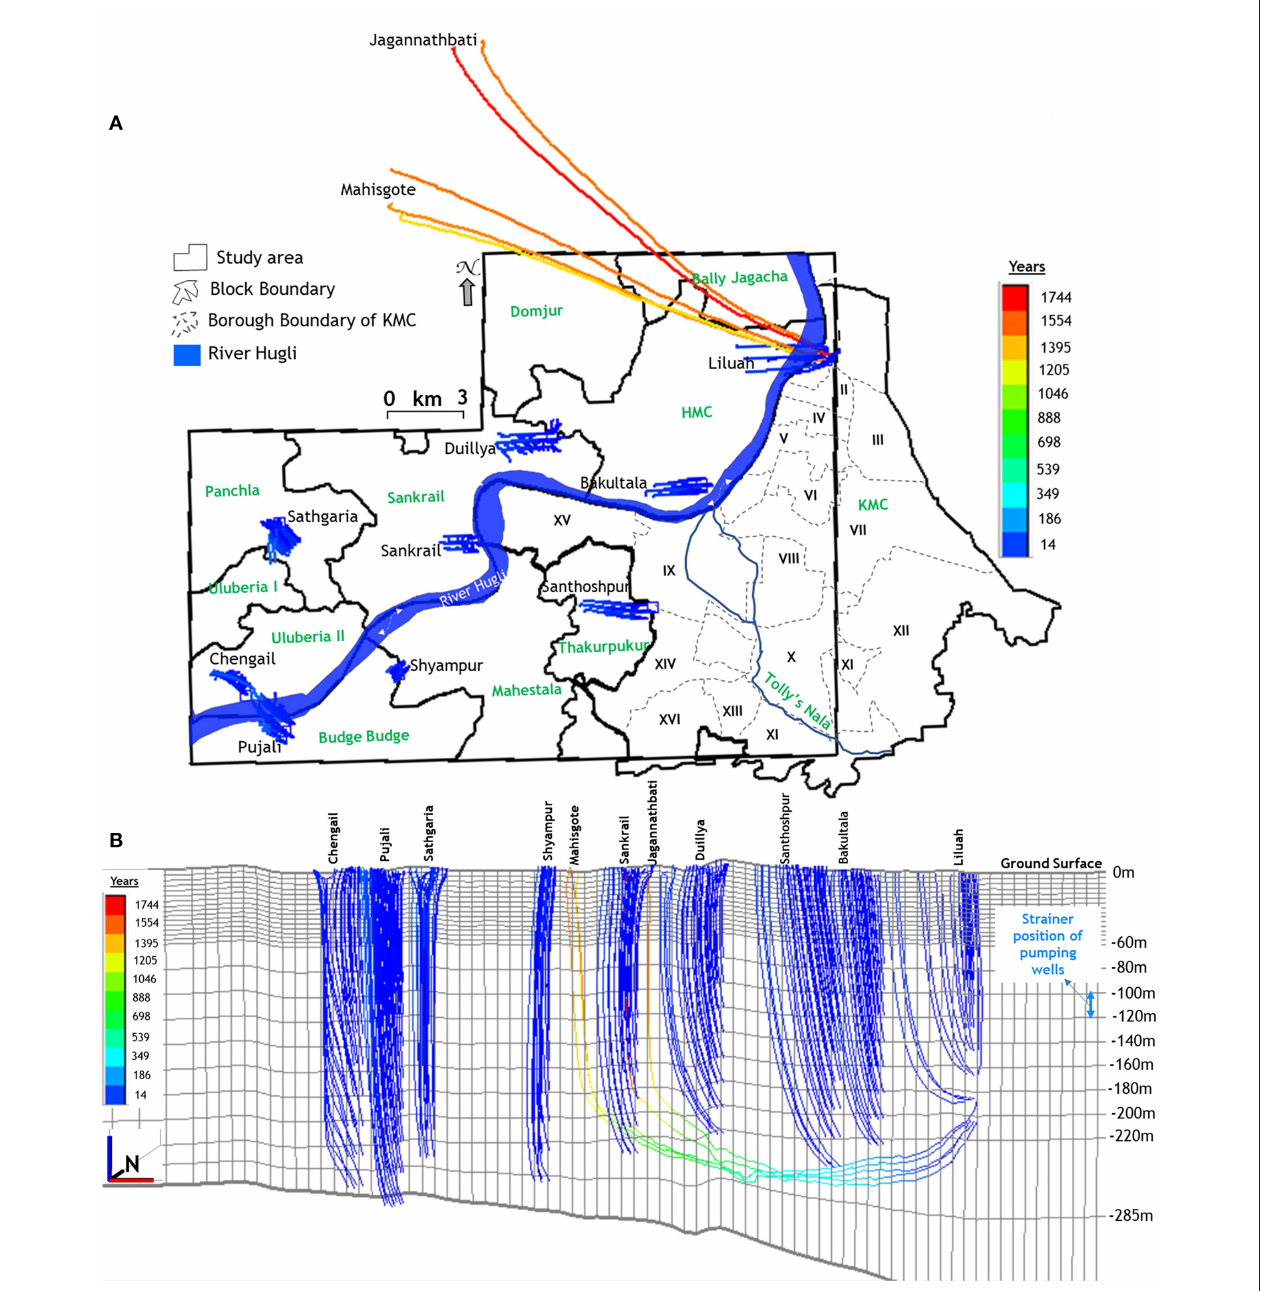
FIGURE 15 | (A) Path lines and endpoints of backward tracked particles from the screen depth of wells having heavy metals under present development pumping conditions. (B) 3-D view of particle path lines of backward tracked particles from the screen depth of wells having heavy metals under present development pumping conditions; vertical exaggeration is